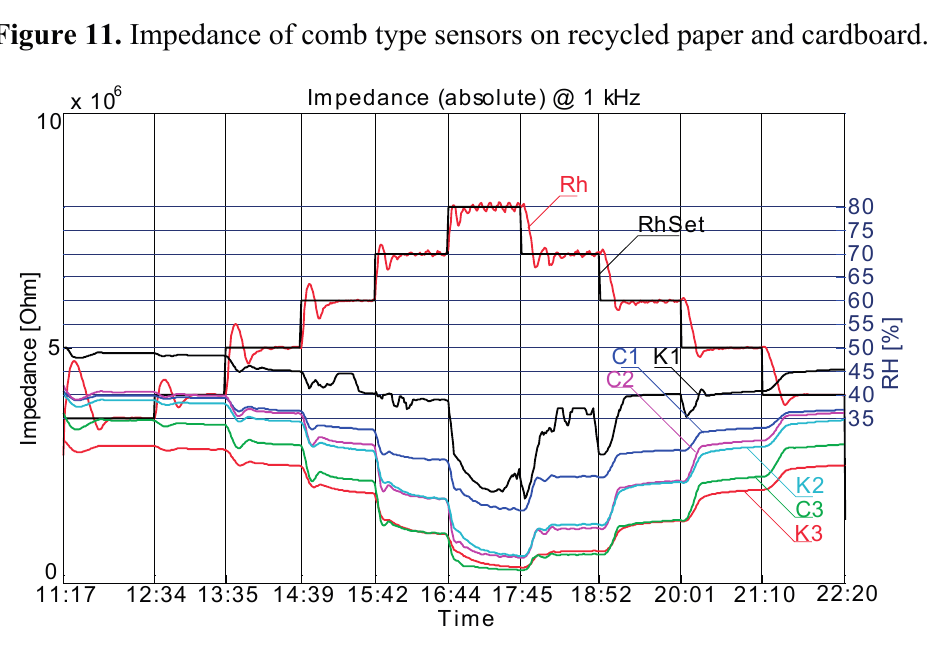
Figure 12. Impedance vs. RH plot of comb type sensors on recycled paper and